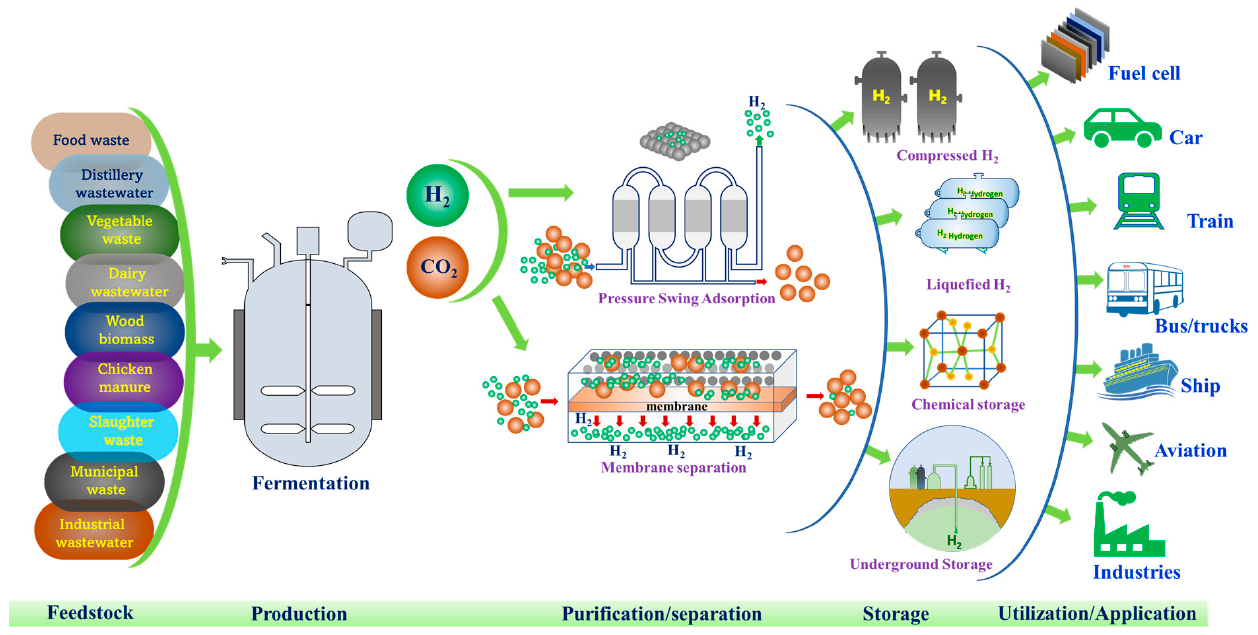
Figure 3. Various stages involved from production to utilization of low-carbon hydrogen from biogenic waste/water as renewable feedstock.